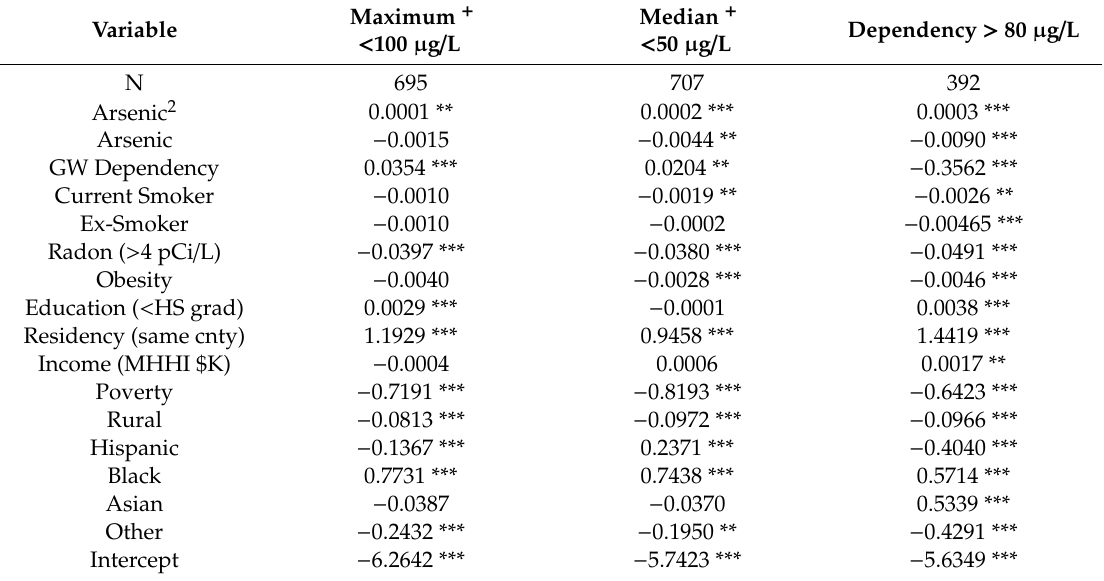
Table 3. Adjusted Poisson Regression Models + of Median Arsenic Exposure and Prostate